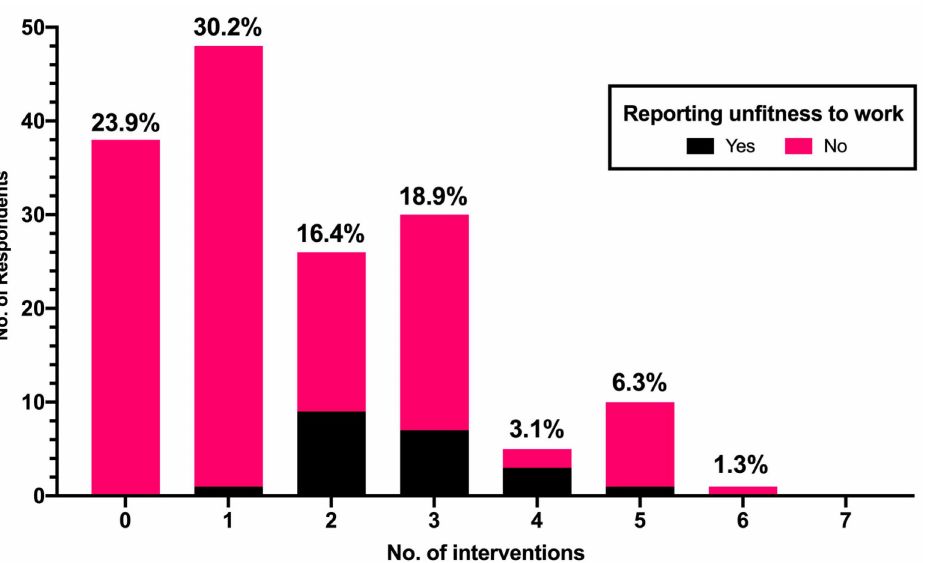
Figure 2. Number of interventions for migraine as reported by participants having any previous interaction with migraineur workers (No. 159 out of 242 total participants).